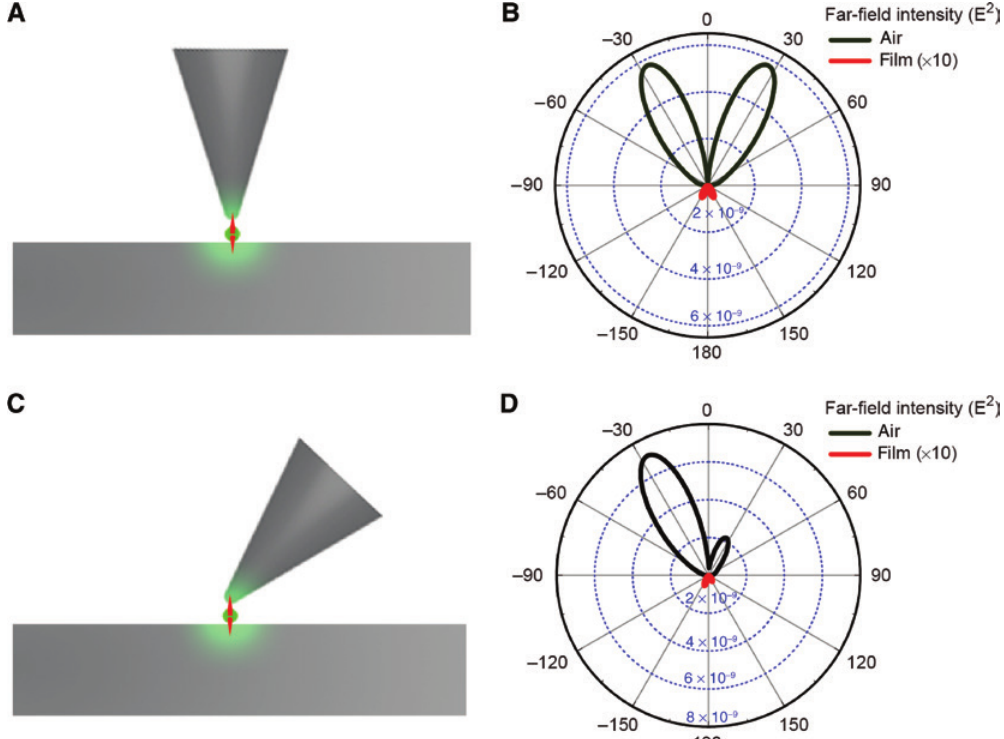
Figure 2: Calculated far-field intensities for the vertically and obliquely placed tips. The angle-resolved emission patterns of the TES in the xz-plane obtained for (A) and (B) a dipole emitter with a vertically placed Ag tip of α = 0 ° , (C) and (D) a dipole emitter with a obliquely placed Ag tip of α = 15 ° . The red arrow in (A) or (C) indicates the vibration orientation of the dipole emitter. The intensities from the film side in (B) and (D) are enlarged 10